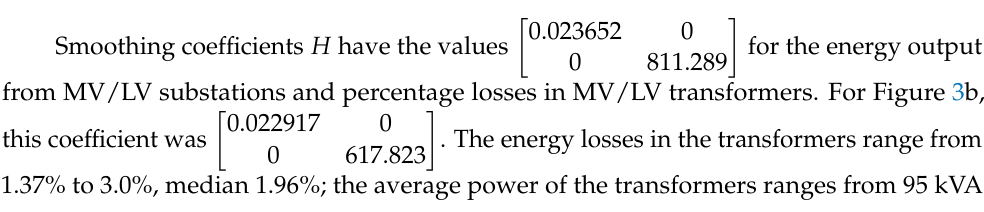
Figure 3. Two-dimensional density function obtained by means of KDE function for: ( a ) average energy per station and power losses in transformer MV/LV, ( b ) average station power and power losses in transformer